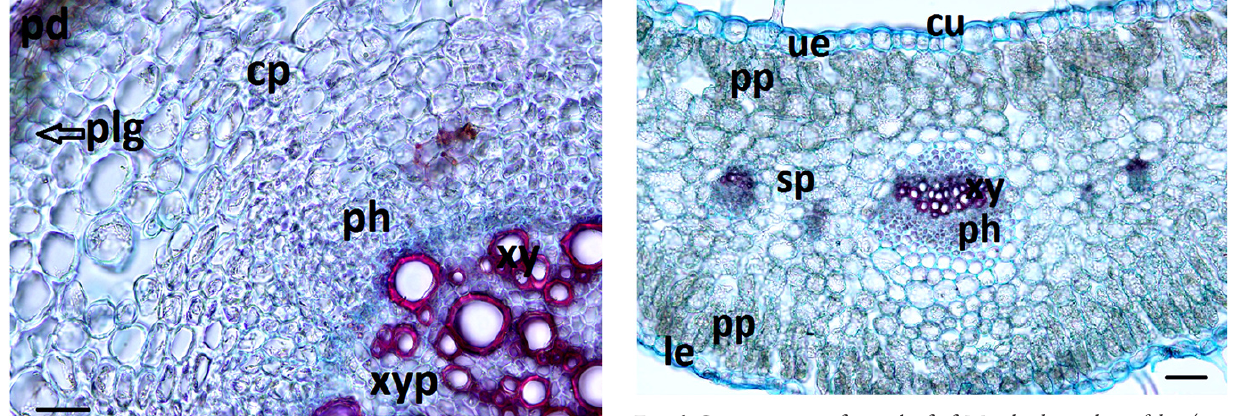
Fig. 6. Cross section of stem leaf of Matthiola anchoniifolia : (cu: cuticle; eh: epidermal hair; le: lower epidermis; ph: phloem; pp: palisade parenchyma; sp: spongy parenchyma; xy: xylem (Scale bar: 60